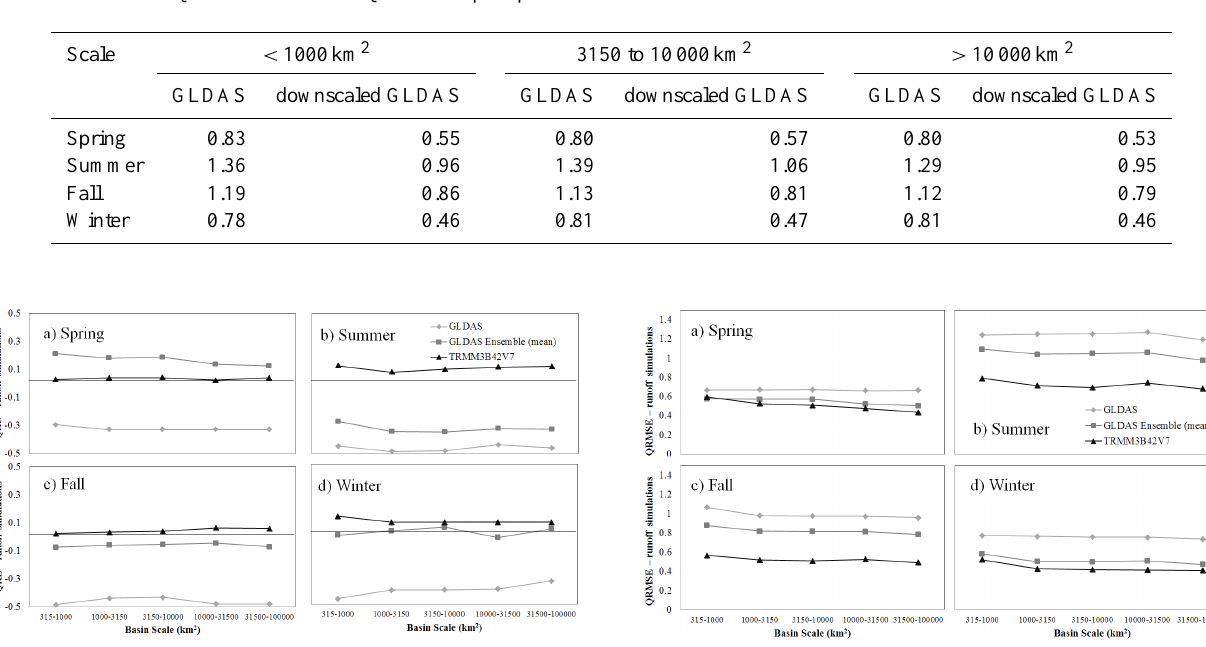
Figure 13. QRMSE error metric determined conditional to refer- ence runoff values exceeding their 90th percentile. The horizontal axis indicates basin-scale categories presented in Table 2. Results are presented for spring (upper left panel), summer (upper right), fall (lower left), and winter (lower right)